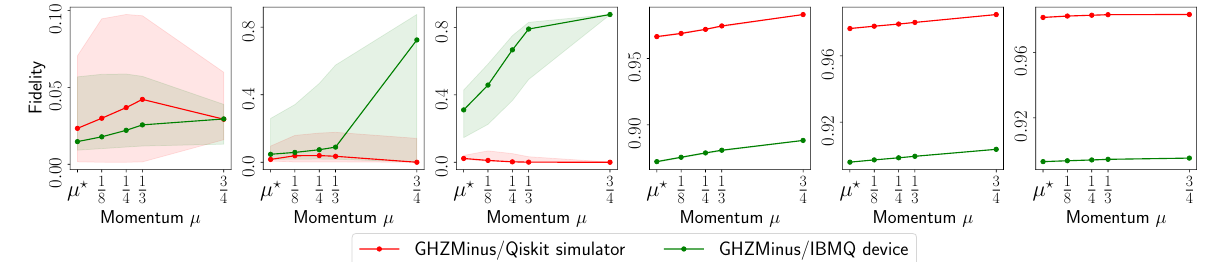
Figure A3. Convergence iteration plots for reconstructing GHZ ments from IBM Quantum system experiments and synthetic measurements from Qiskit simula- tion experiments.